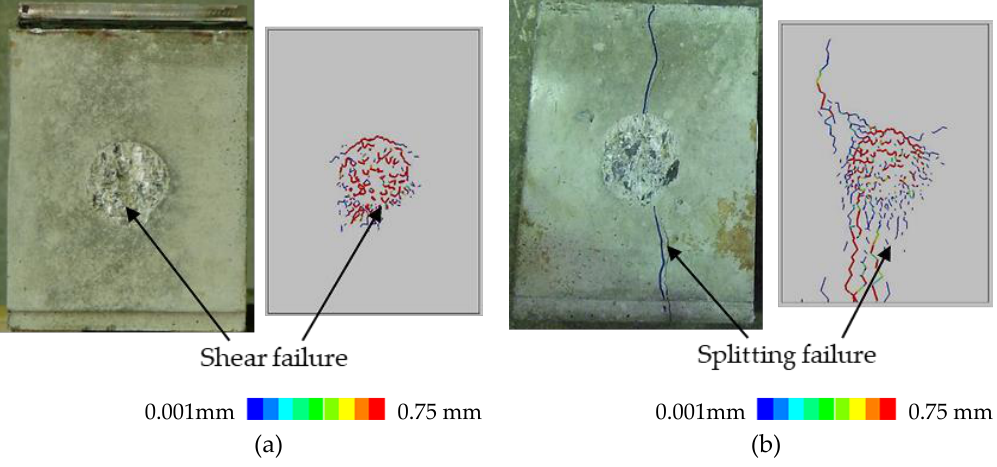
Figure 9. Comparison of test and analytical failure modes: ( a ) Low lateral pressure (2 MPa) case; ( b ) High lateral pressure (10 MPa) case.